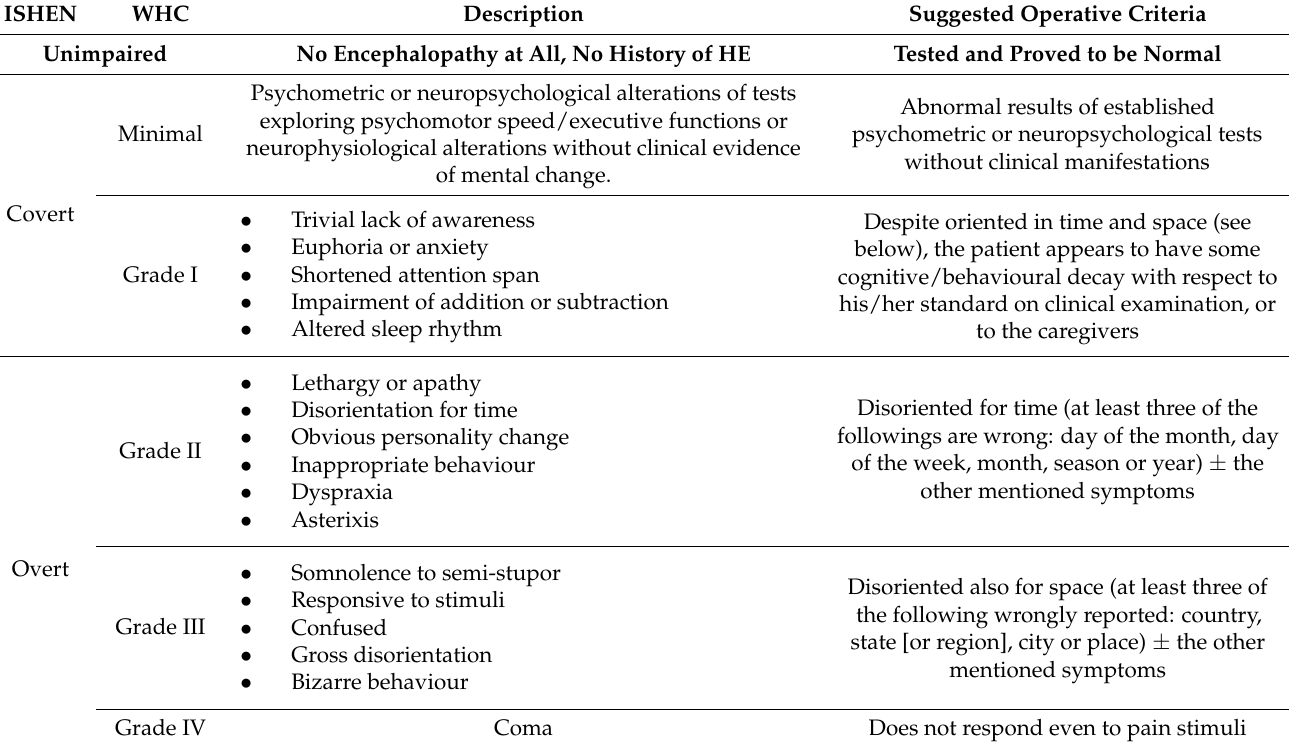
Table 1. Clinical presentation of hepatic